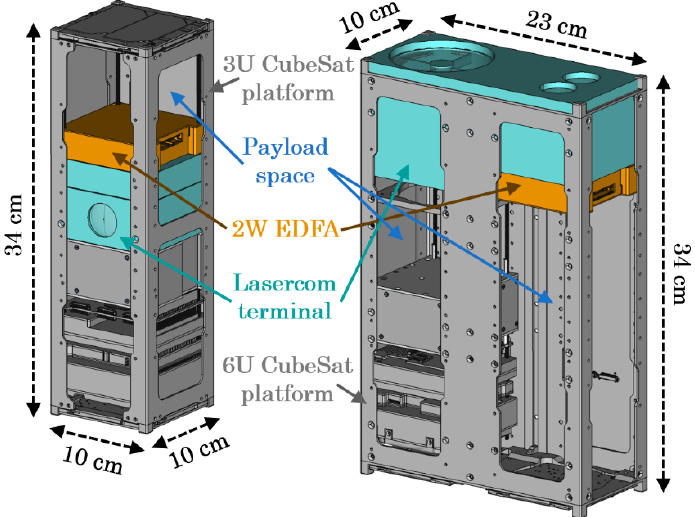
Figure 1. Three-dimensional model of CubeSOTA showing the EDFA within the lasercom terminal and its impact on the CubeSat’s platforms.